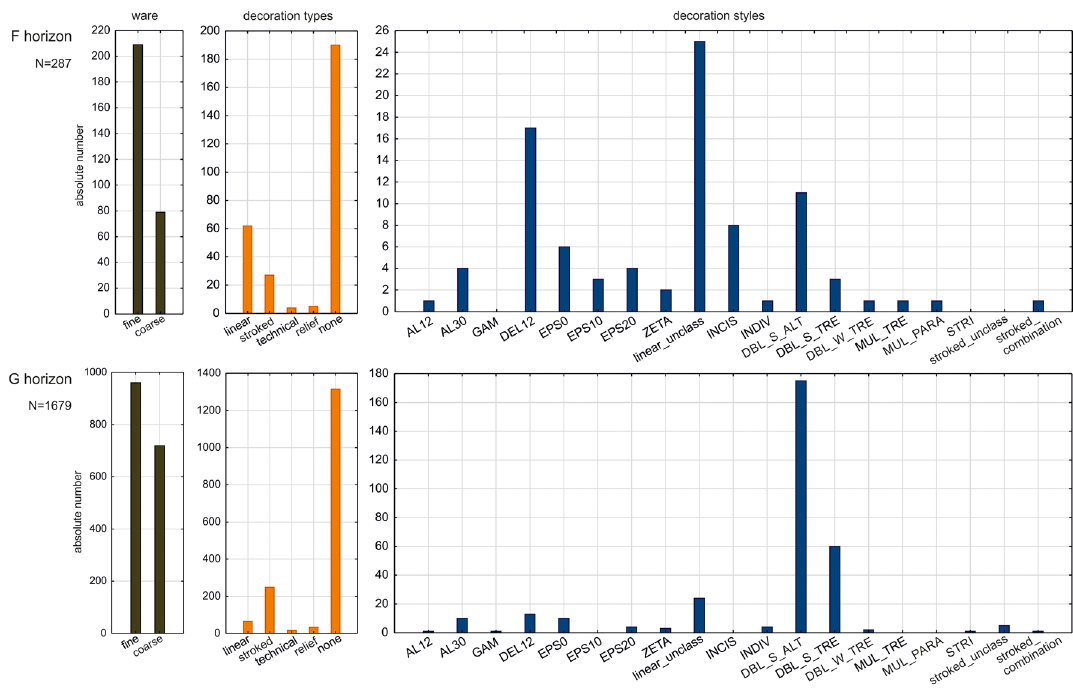
Figure 7. Attributes of F and G horizons ceramic assemblages. For styles abbreviations see Figure